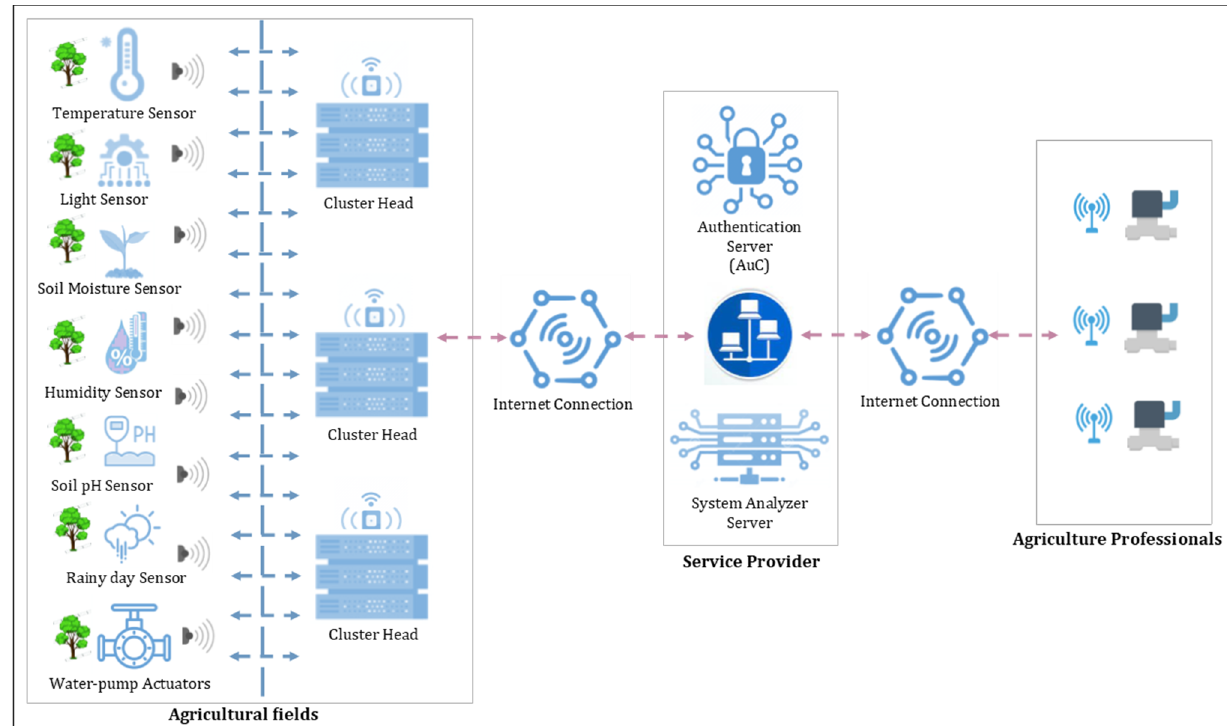
Figure 1. Proposed smart IoT irrigation system architecture.